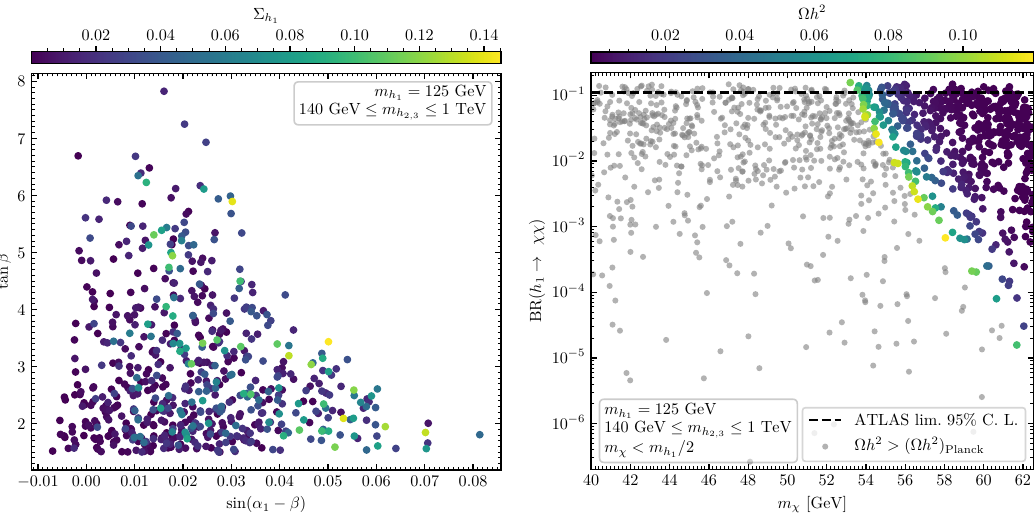
Figure 3 . Left: tan β in dependence of sin( α 1 − β ) for the parameter points that pass all the constraints discussed in section 3. Right: invisible branching ratio BR( h 1 → χχ ) in dependence of m χ for the parameter points with m χ < m h / 2 that pass the constraints, not taking into account 1 the experimental upper limit on BR( h 1 → χχ ) as reported by ATLAS [101]. The colour coding indicates Σ h 1